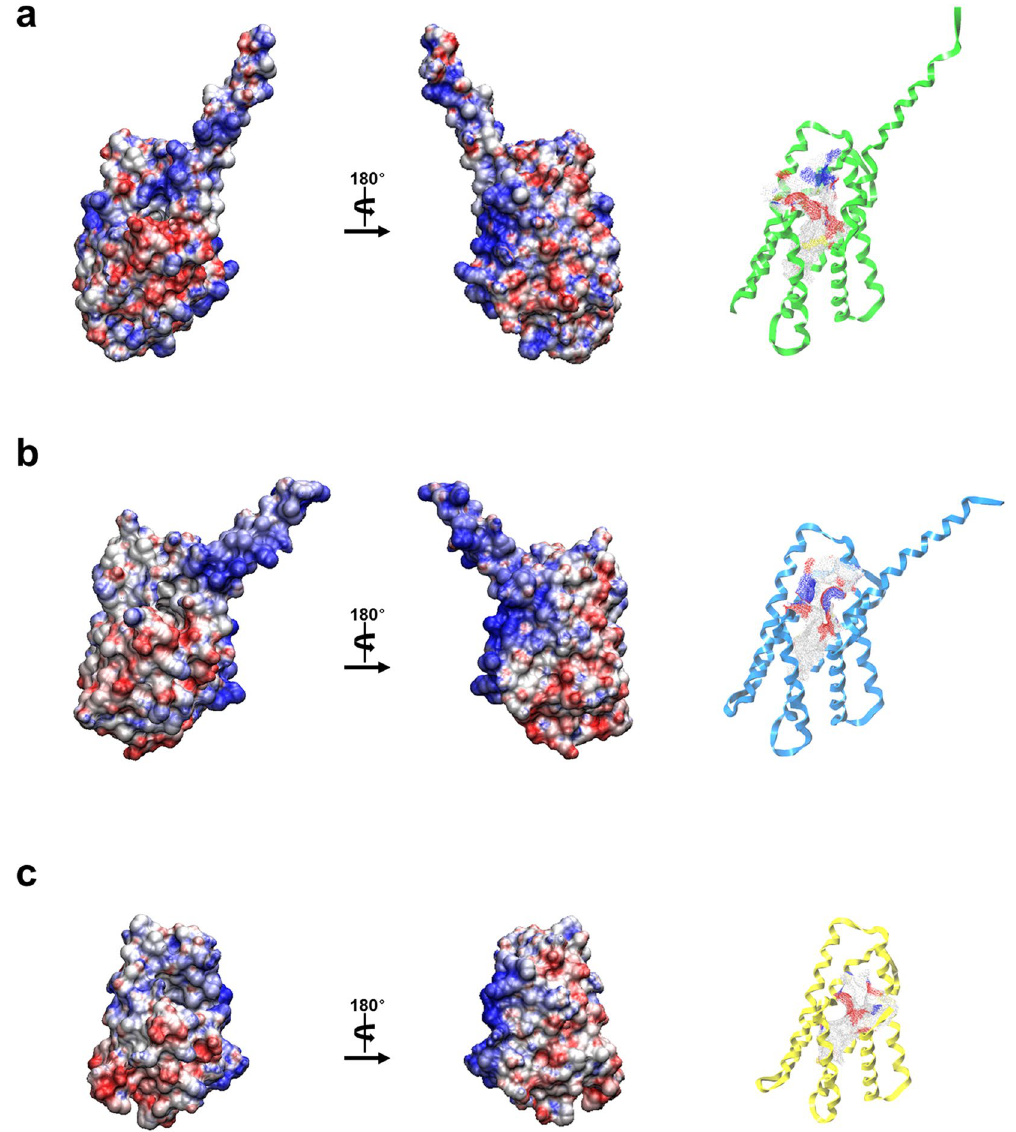
Figure 4. Structural comparison of ( a ) mTnfaip8, ( b ) hTIPE2 and ( c ) hTIPE3. The surface of the protein is drawn with an electrostatic surface model. Molecular surfaces were created by the VMD molecular-graphics software package 33 following electrostatic calculations using APBS 34 (red, negative; blue, positive; white, uncharged). The cavity is found and is depicted inside the ribbon diagram using the MOLCAD program of SYBYL-X2.0. The surface color of the cavity is represented according to the charge of residues comprising the